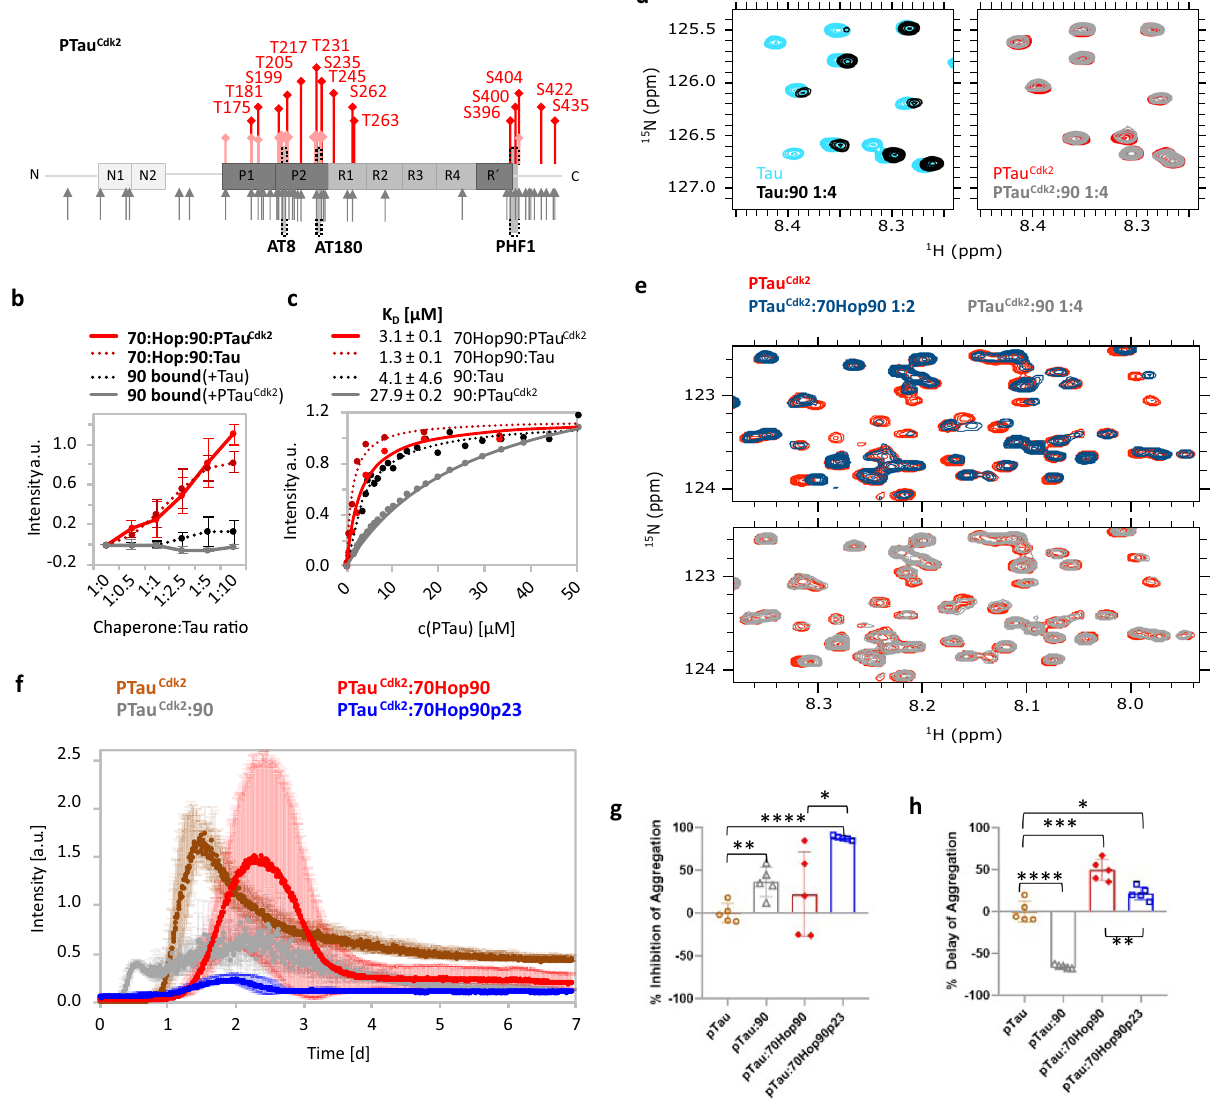
Fig. 6 Pathologically modi fi ed Tau binds to the Hsp70/Hsp90 multichaperone chaperone complex but not to Hsp90 alone. a Phosphorylation of Tau by